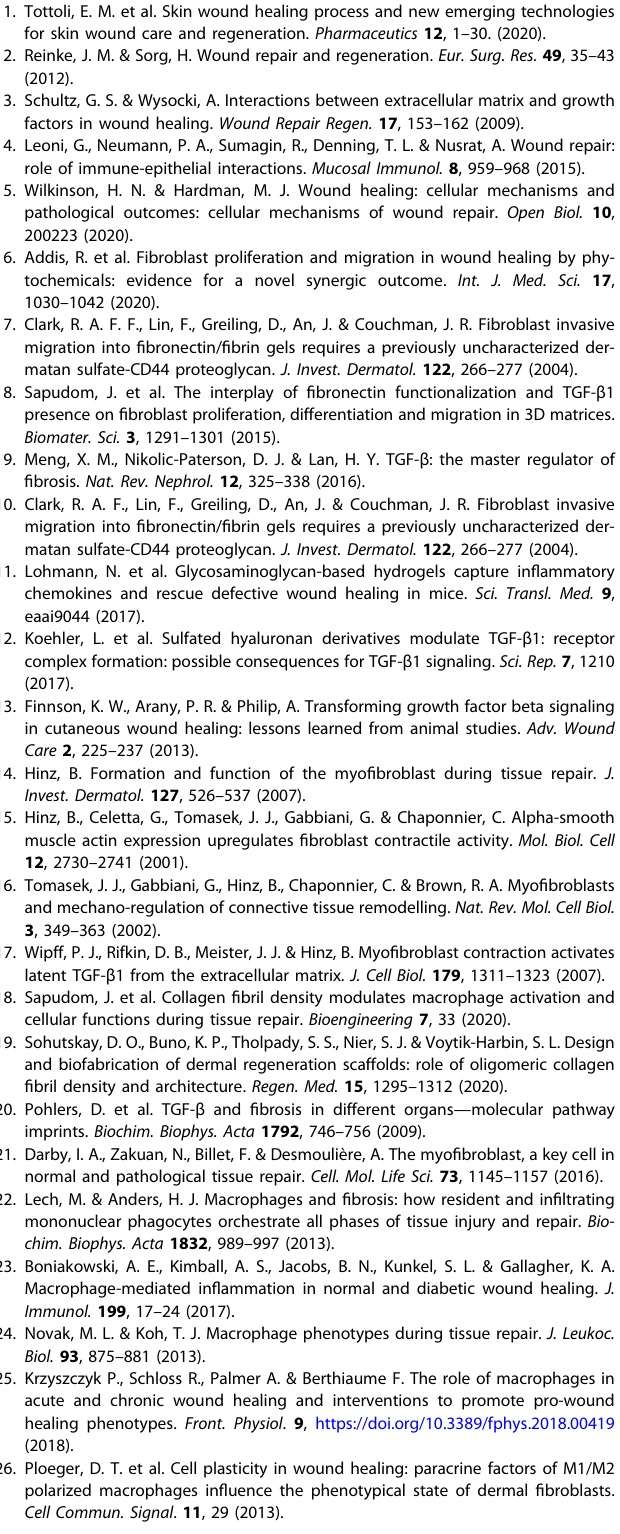
Supplementary Table 2. To con fi rm the speci fi city of the PCR products, melting curve analysis was performed at the end of each run. Both cDNA synthesis and qPCR were conducted using Stratagene Mx3005P (Agilent Technologies, CA, USA). The relative expression levels were calculated using the 2 − ΔΔ CT method. Experiments were undertaken in four